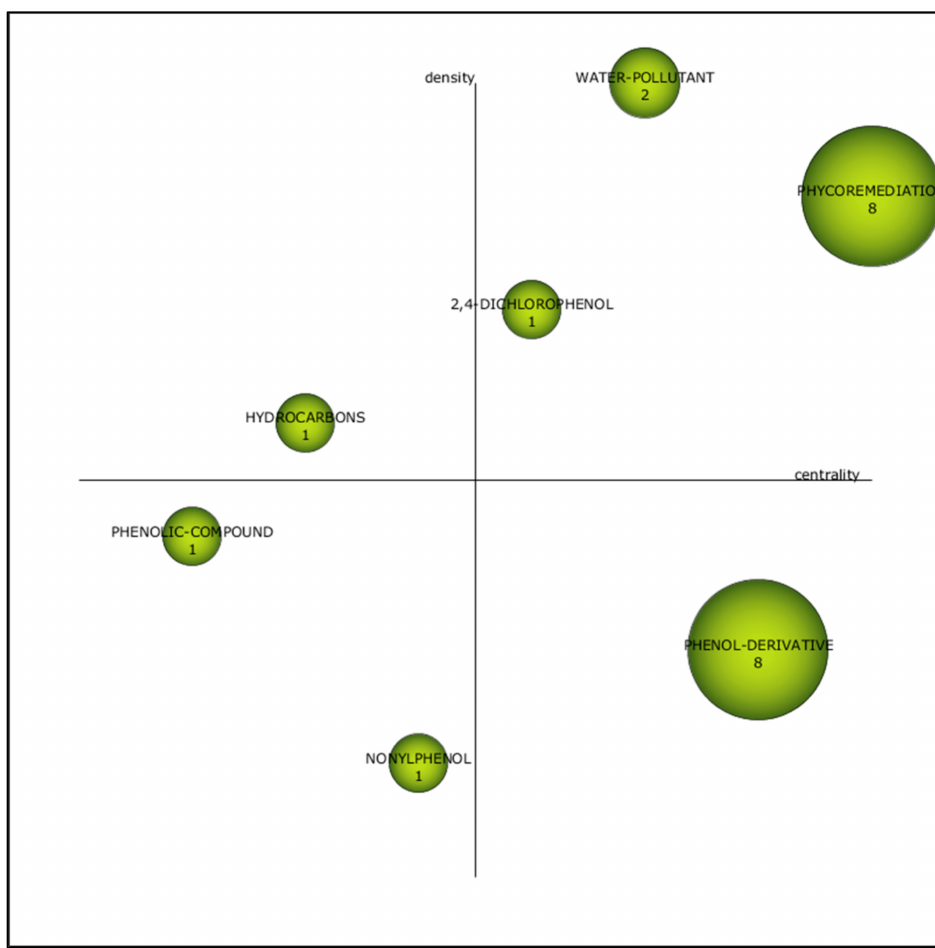
Figure 6. Strategic diagram for the first period